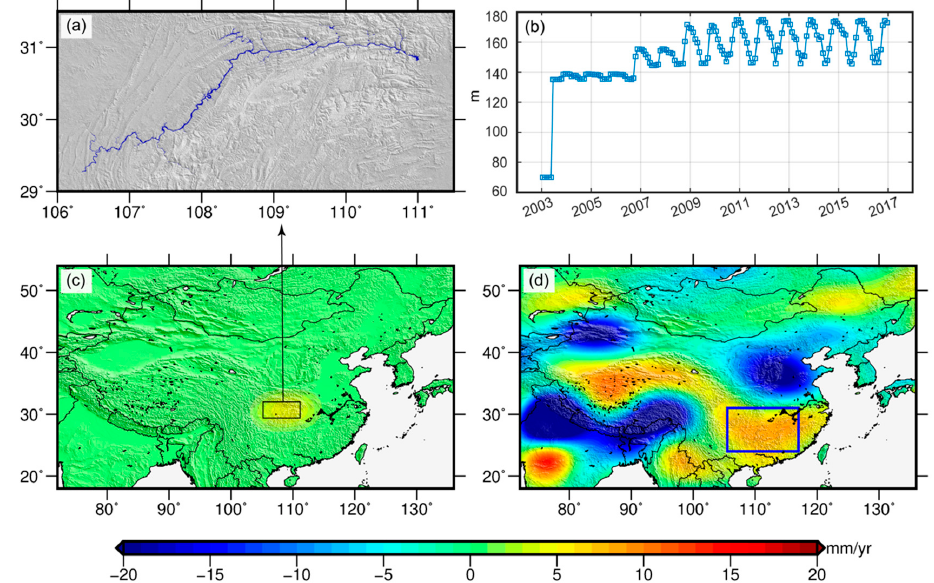
Figure 2. Influence of the Three Gorges Reservoir: ( a ) map of the reservoir; ( b ) the water level change of the reservoir; ( c ) trend of the water change from January 2003 to August 2016 after truncating the order to 60 and filtering by DDK4; and ( d ) mass change after removing the effects of reservoir and lakes.